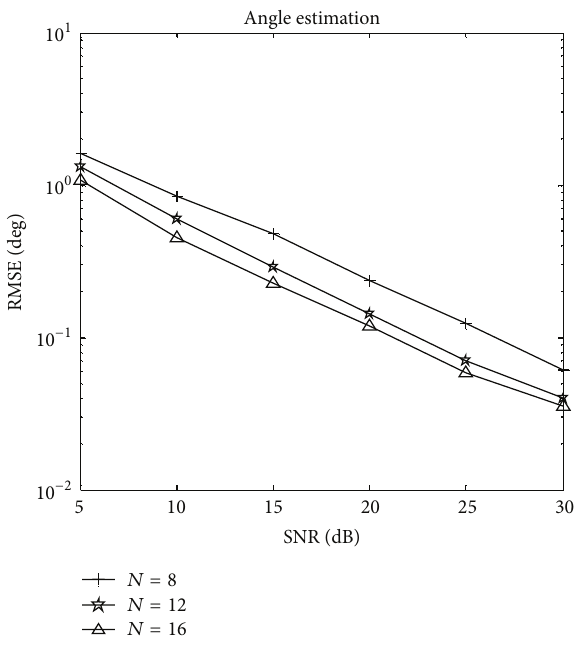
Figure 10: Angle estimation performance with 𝑀 = 8 and different values of 𝑁 .